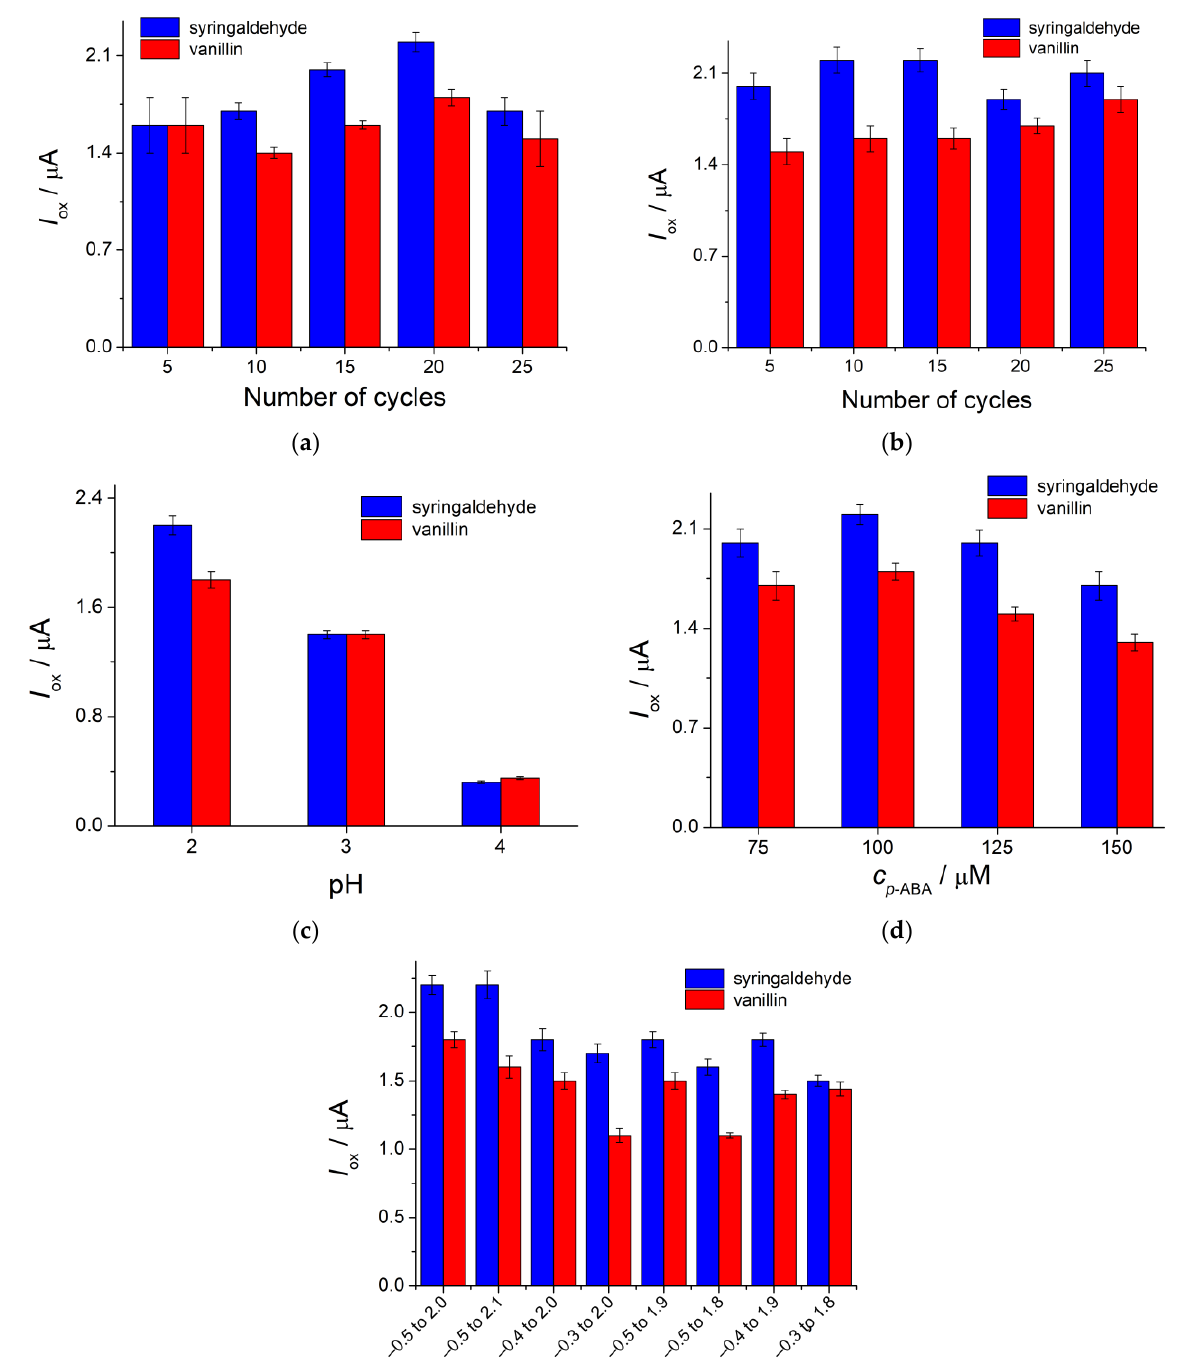
Figure 3. Changes in the oxidation currents of 10 µM mixture of syringaldehyde and vanillin at the polymer-modified electrode depending on the: ( a ) number of cycles at υ = 100 mV · s − 1 ; ( b ) number of cycles at υ = 150 mV · s − 1 ; ( c ) supporting electrolyte pH; ( d ) monomer concentration; ( e ) polarization window used for the poly( p -ABA) layer electrodeposition. The response of aromatic aldehydes is recorded in Britton–Robinson buffer pH 2.0 using cyclic voltammetry at a potential scan rate of 100 mV · s − 1